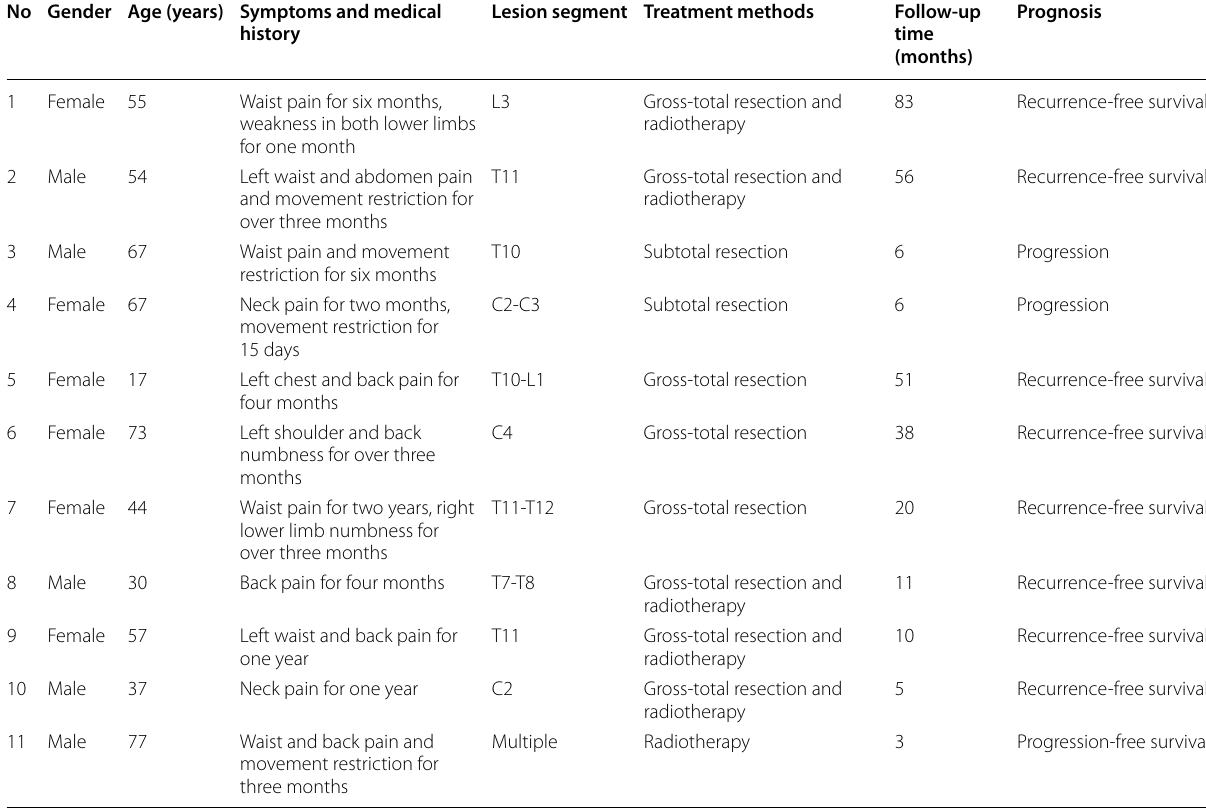
Table 1 General information of the 11 patients with primary leiomyosarcoma of the spine No Gender Age (years) Symptoms and medical